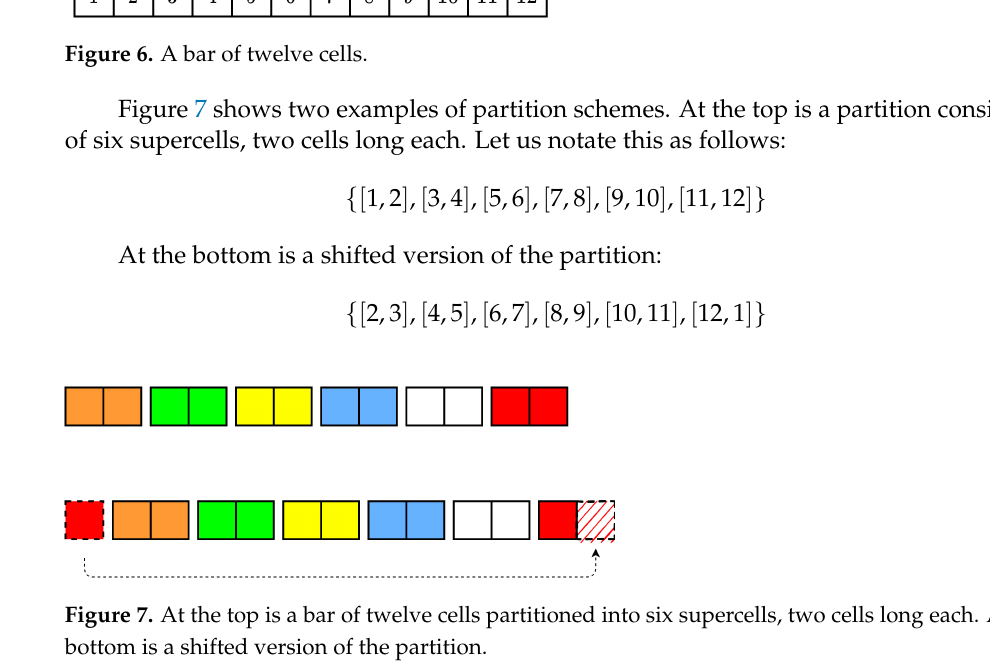
Figure 6. A bar of twelve cells.